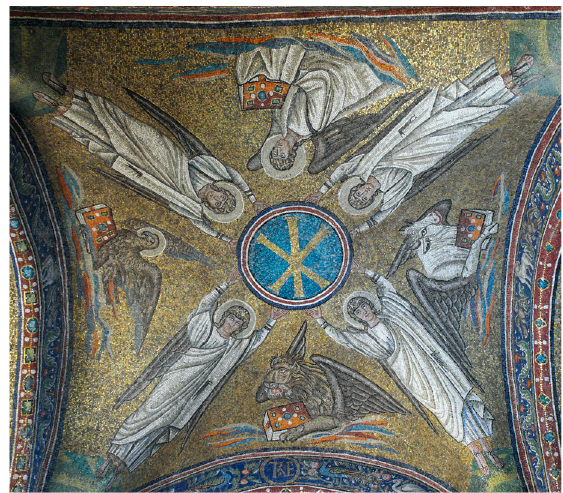
Figure 6. Mosaic vault, Archiepiscopal Chapel, Ravenna (photo: GFreihalter, Wikimedia Commons, CC BY-SA 3.0, cropped).